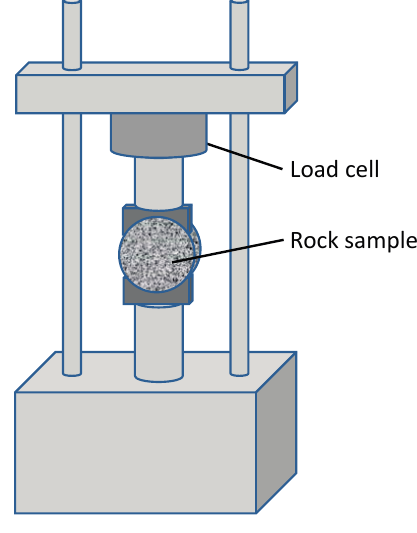
Figure 4. Brazilian